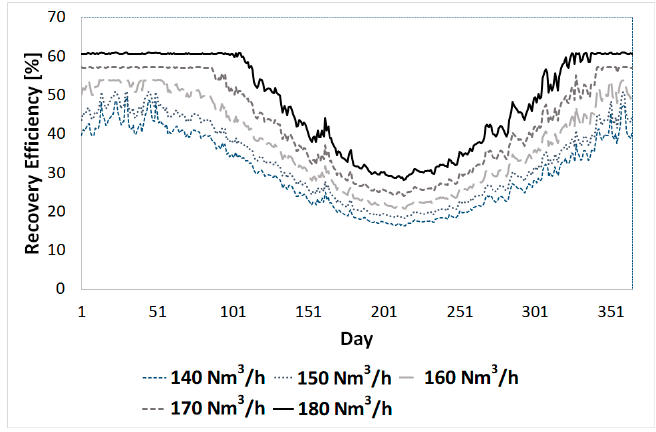
Figure 17. The total efficiency for various bio-methane productions.